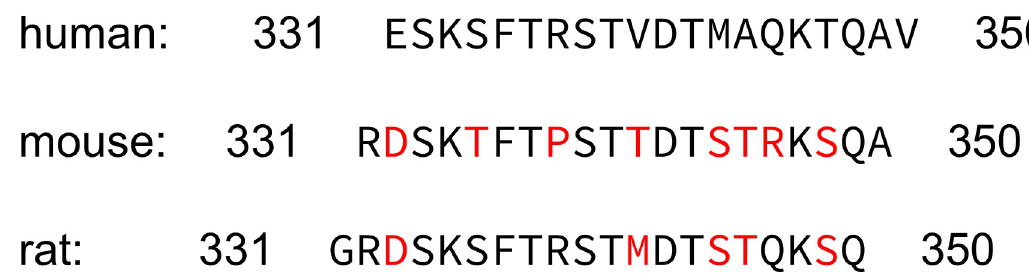
Fig 1. Carboxy-terminal sequence of human, mouse, and rat C5aR1. Differences in amino acid sequences of rat and mouse C5aR1 in comparison with the human receptor are marked in